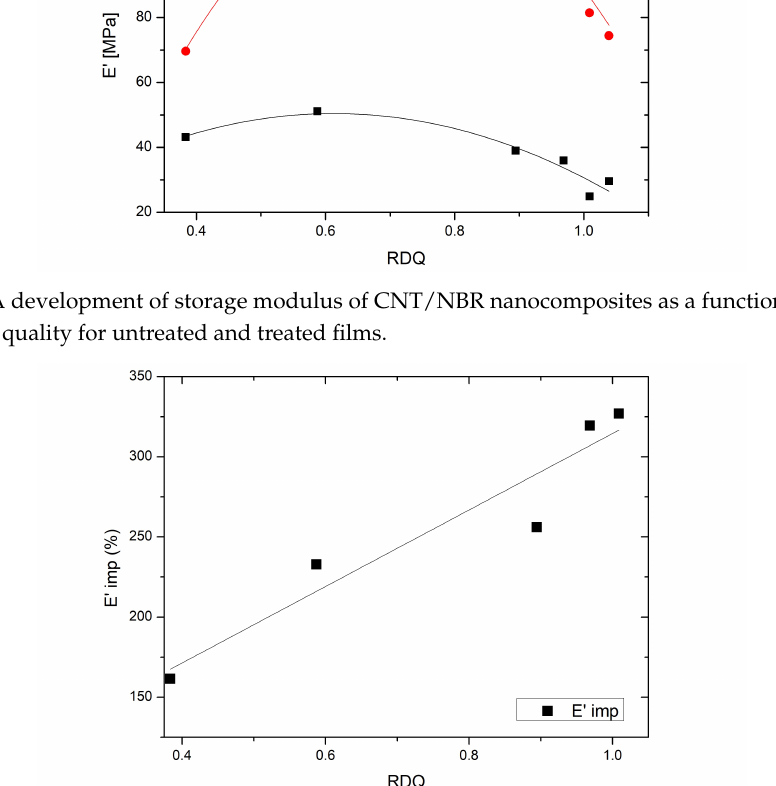
Figure 9. A development of relative improvement due to the post treatment of the storage modulus of CNT/NBR nanocomposites as a function of relative dispersion